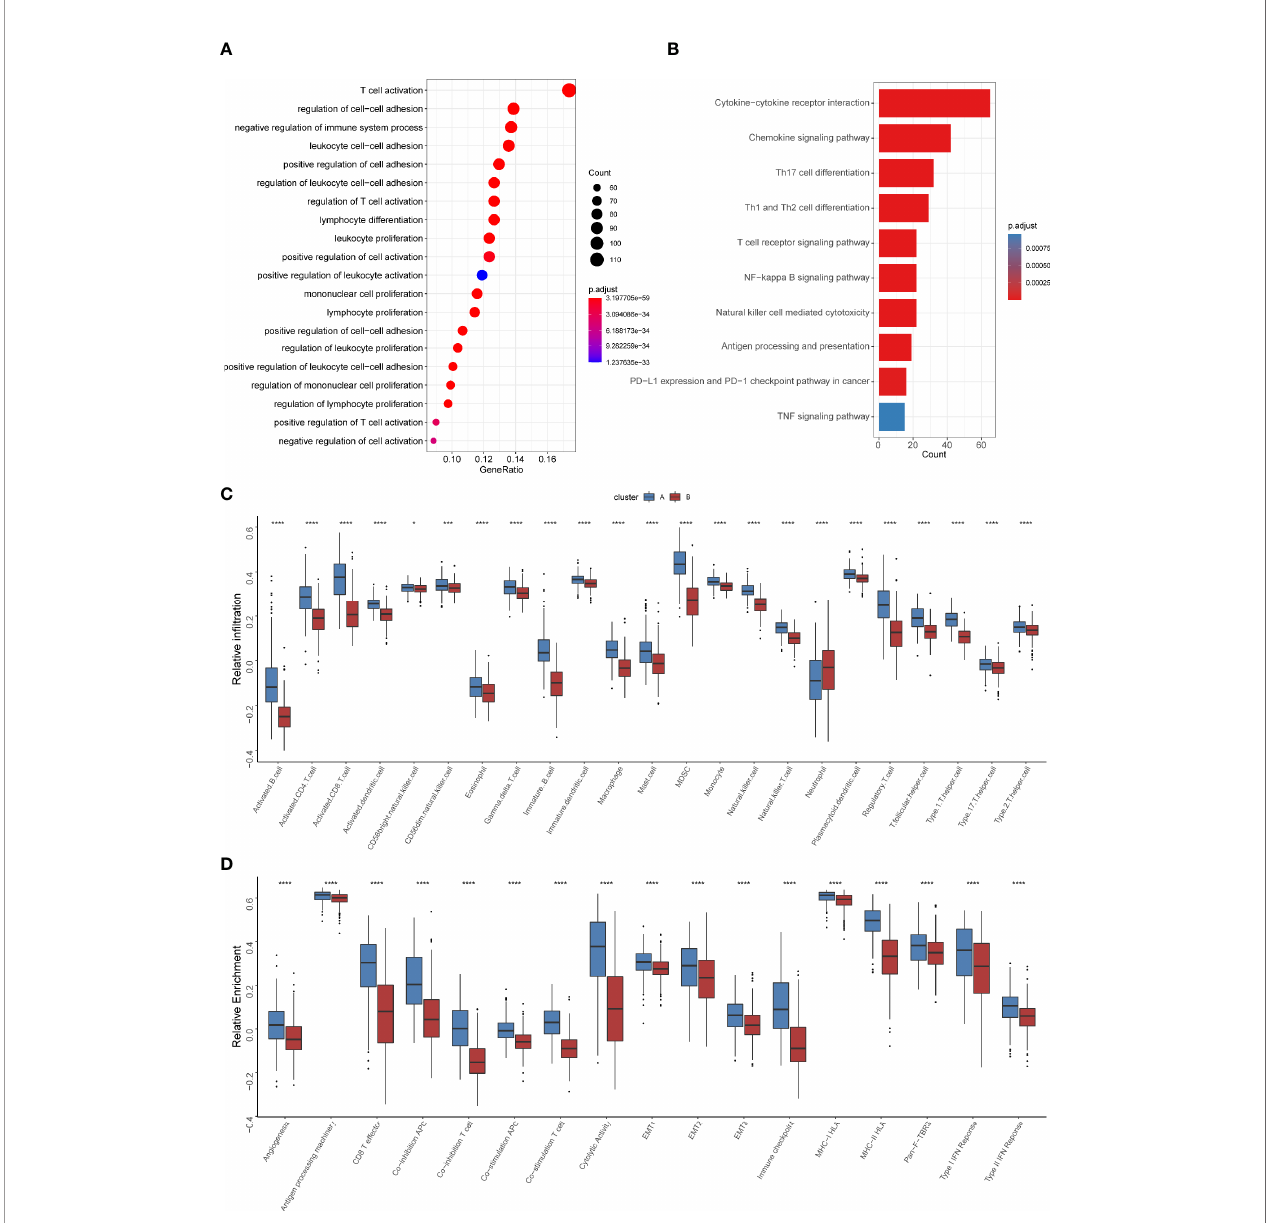
FIGURE 4 | Differential immune characteristics of TNF pattern A and B (A) Gene Ontology (GO) analysis depicted the enriched pathways of TNF-related genes. (B) Kyoto Encyclopedia of Genes and Genomes (KEGG) pathways analysis of TNF-related genes. (C) Relative in fi ltration of 23 types of immune cells in TNF cluster A and B (D) Relative enrichment score of 17 immune related signatures in TNF cluster A and B. (* p < 0.05, *** p < 0.001, **** p <